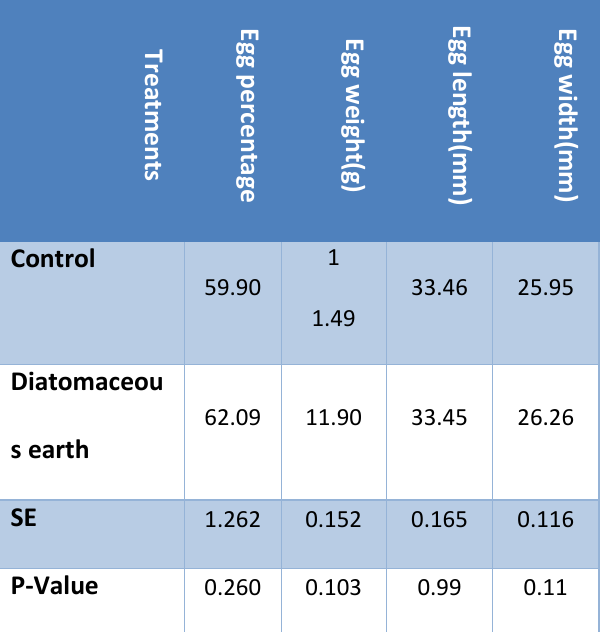
Table, 2: Evaluation of diatomaceous earth on egg production and its characteristics in quail